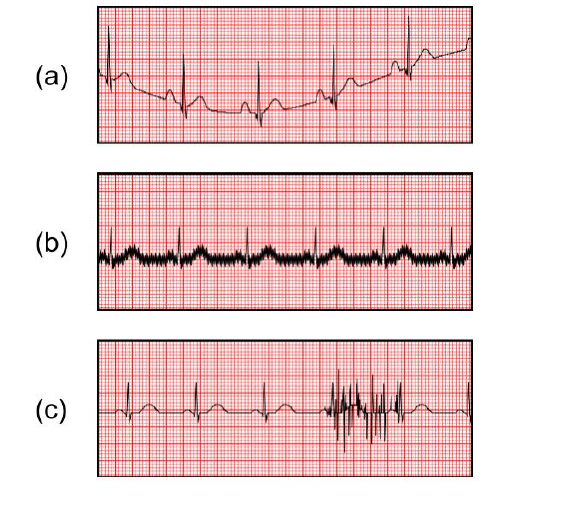
Figure 10. ECG Artifact examples: ( a ) Baseline Wander, ( b ) Power line Interference, ( c ) Muscle Interference.